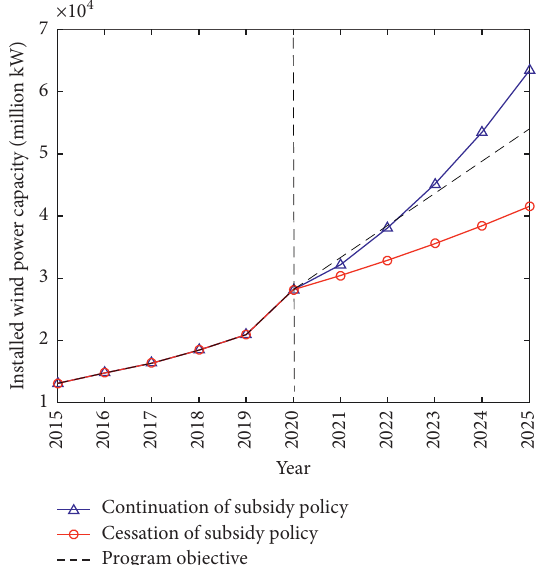
Figure 5: Comparison chart of forecast results of wind power installed capacity.